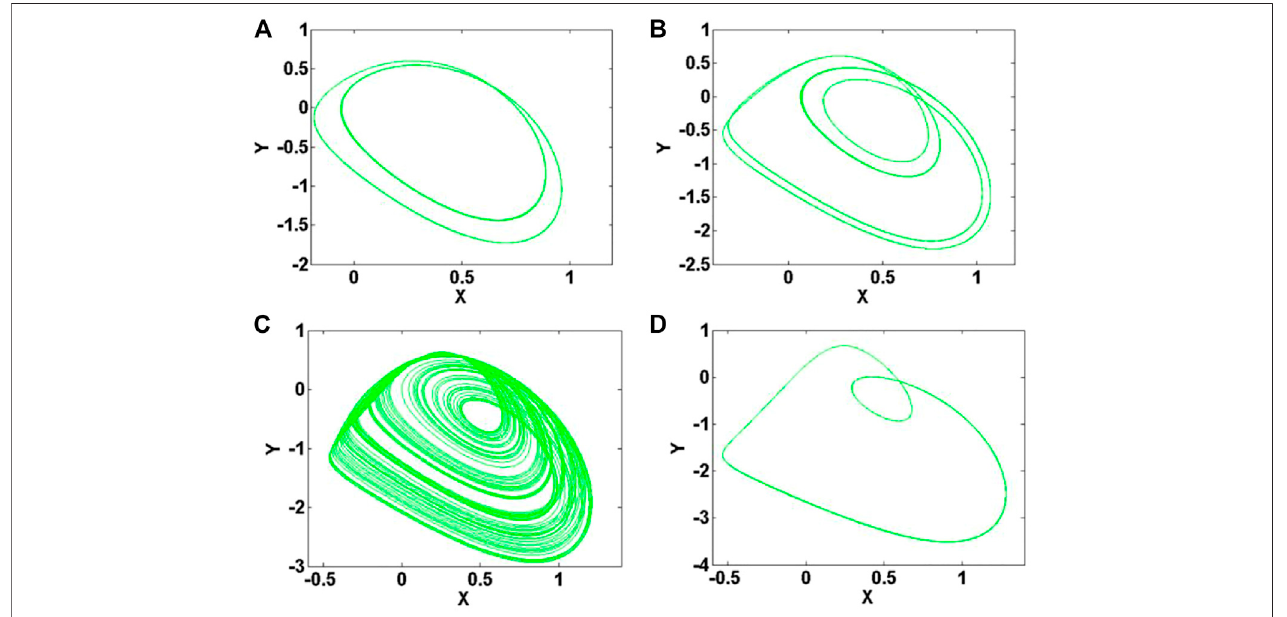
FIGURE 10 | Dynamics of system (10) with b (cid:1) 5.5, c (cid:1) 1.7, d (cid:1) 2.5 and initial condition (0, 0, 0): (A) a (cid:1) 2.2, (B) a (cid:1) 2.5, (C) a (cid:1) 2.8, (D) a (cid:1) 3.